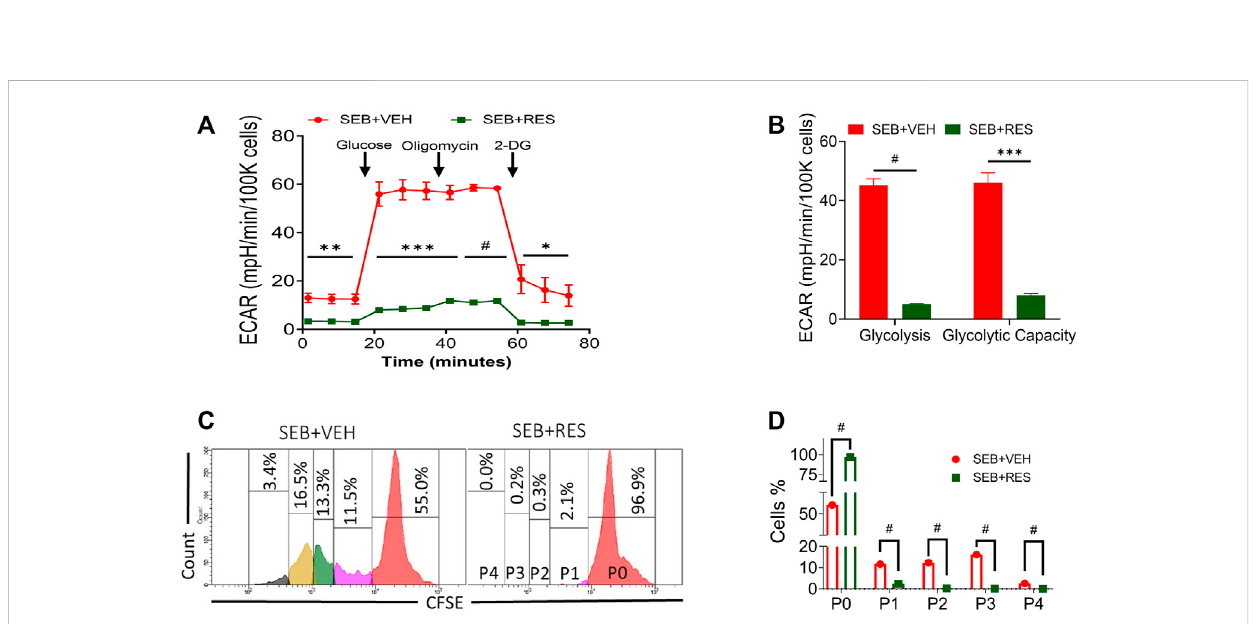
Single-cell RNA-sequencing (scRNA-seq) reveals downregulation of glucose metabolism-related genes post-RES treatment. Mice were treated as mentioned in Figure 1 legend. Whole lung tissues were excised and a single cell suspension was prepared. scRNA-seq was performed as described in Methods. The cells studied included: Mac: macrophages, Neut: Neutrophils, T: T cells, (B) B cells, AM: Alveolar macrophages, MDSC: Myeloid-derived suppressor cells, EC: Endothelial cells. MC: Monocytes. (A) scRNA-seq tSNE colored by cell phenotypes. (B) scRNA-seq tSNE colored by group ID consistingofSEB+VEHandSEB+RES. (C) .TheviolinplotdepictstheMtorgeneexpressionlevelsandenrichmentsindifferentlungcellularcomponents. (D) . Violin plot depicts Rac1 gene expression levels and enrichment. (E) . The violin plot depicts Akt2 gene expression levels and enrichment. (F) . Heatmap expression of Hk2 in T cells and NKT